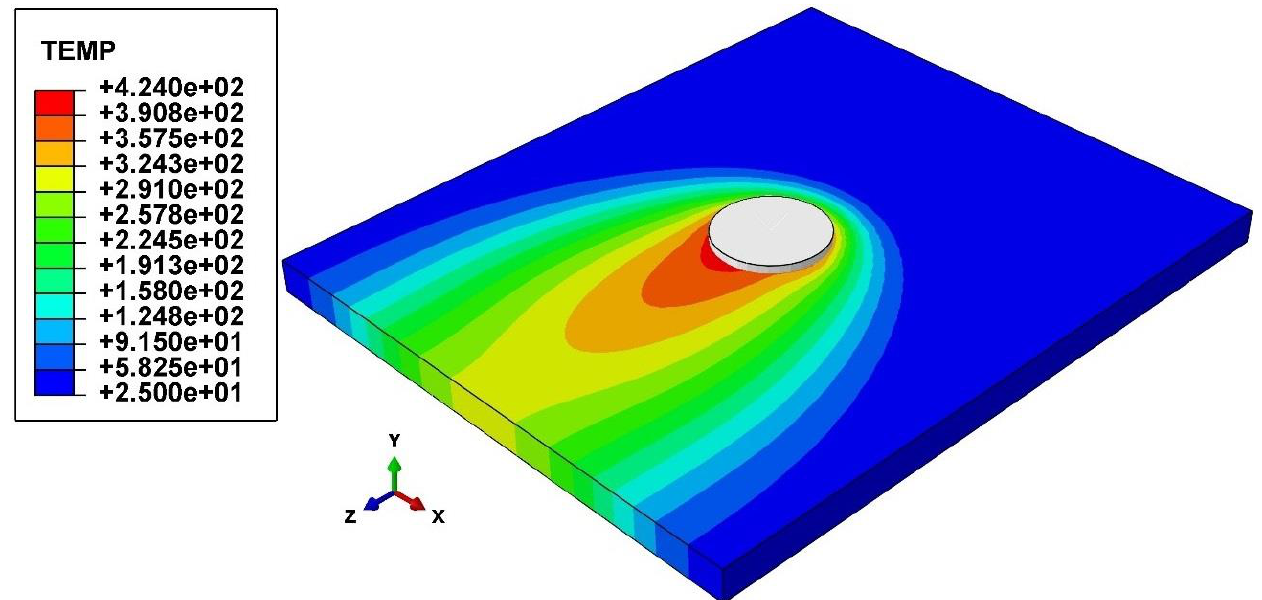
Figure 4. Temperature distribution contour of the verification model.